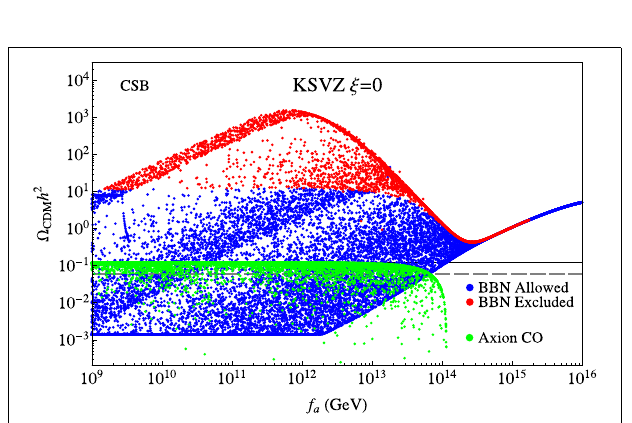
FIGURE 2 | The wino-like WIMP (blue) and axion (green) relic densities from a scan over SUSY KSVZ parameter space for the CSB benchmark case with ξ = 0 . The gray dashed line shows the points where DM consists of 50% axions and 50%